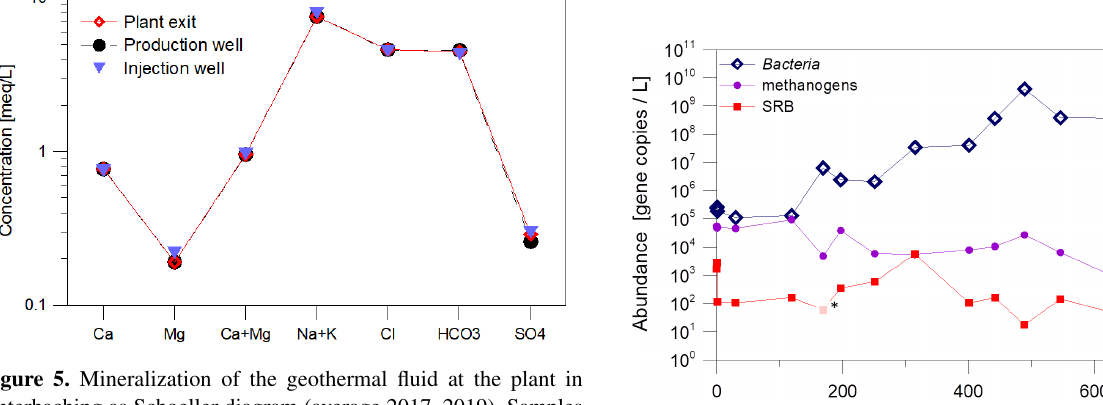
Figure 6. Increase of the abundance of Bacteria due to inhibitor dosage in fluid samples from different sampling sites at the geother- mal plant Unterhaching over a monitoring period of about 700d of inhibitor dosage. Grey values marked with an asterisk were below the sample specific detection limit. Quantification with qPCR with primers for the 16S rRNA gene.